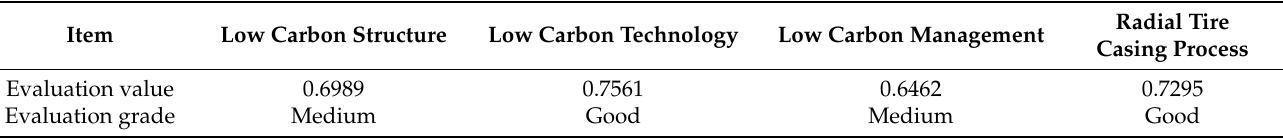
Table 2. Low carbon level evaluation values in the technological process of radial tire casing.